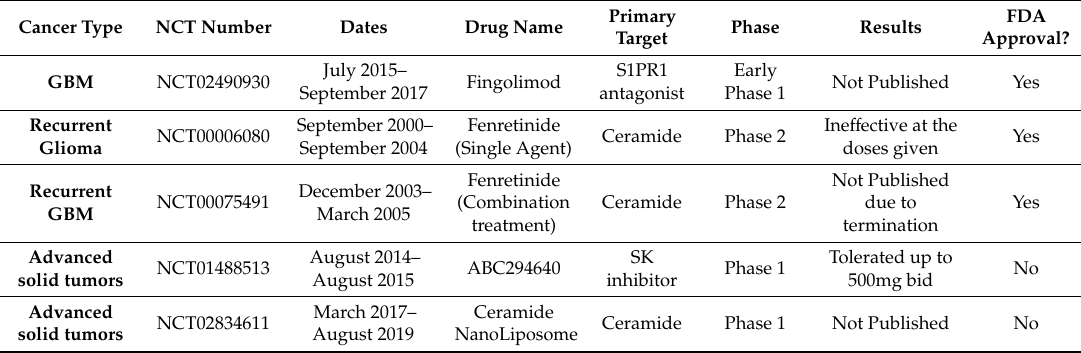
Table 2. Current and previous clinical trials targeting sphingolipid metabolism. Multiple clinical trials have attempted to target sphingolipid metabolism by altering enzymes, receptor expression, and ceramide accumulation in the sphingolipid